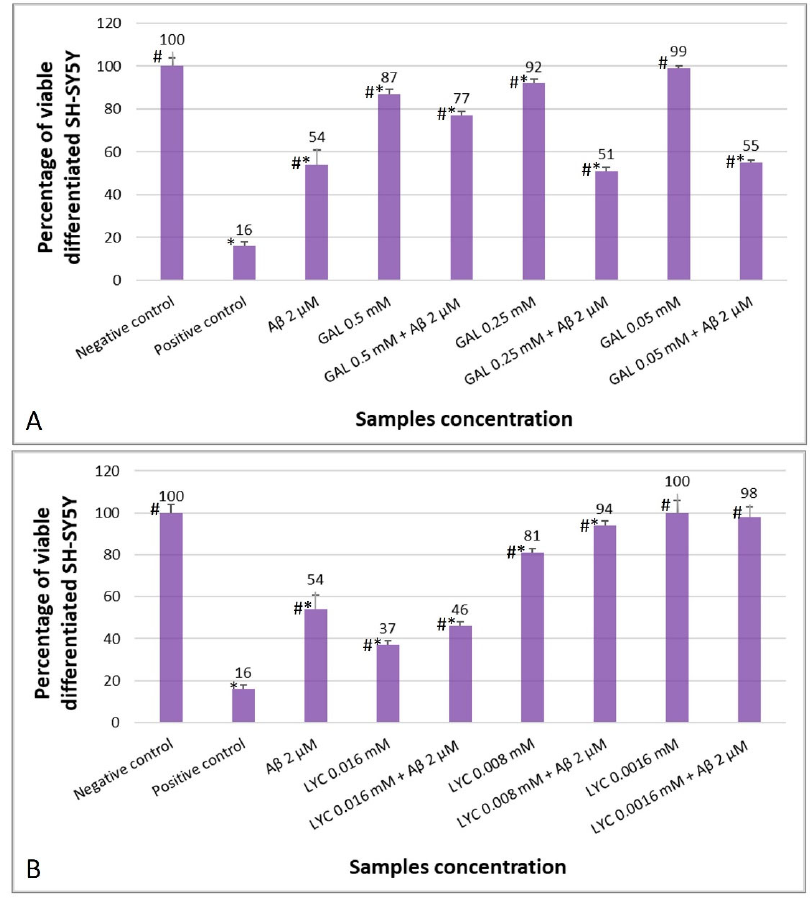
Figure 7. Effect of A β 2 µ M towards viability of differentiated SH-SY5Y as a function of ( A ) GAL and ( B ) LYC concentration, as determined by the Neutral Red Uptake. Data are mean ± SD of three replicates for each sample. * Values are statistically different versus negative control (complete medium), p < 0.05. # Values are statistically different versus positive control (PVC-org.Sn), p < 0.05.